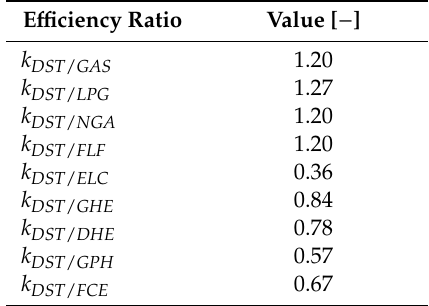
Table 4. E ffi ciency ratios with respect to diesel cars / light trucks.